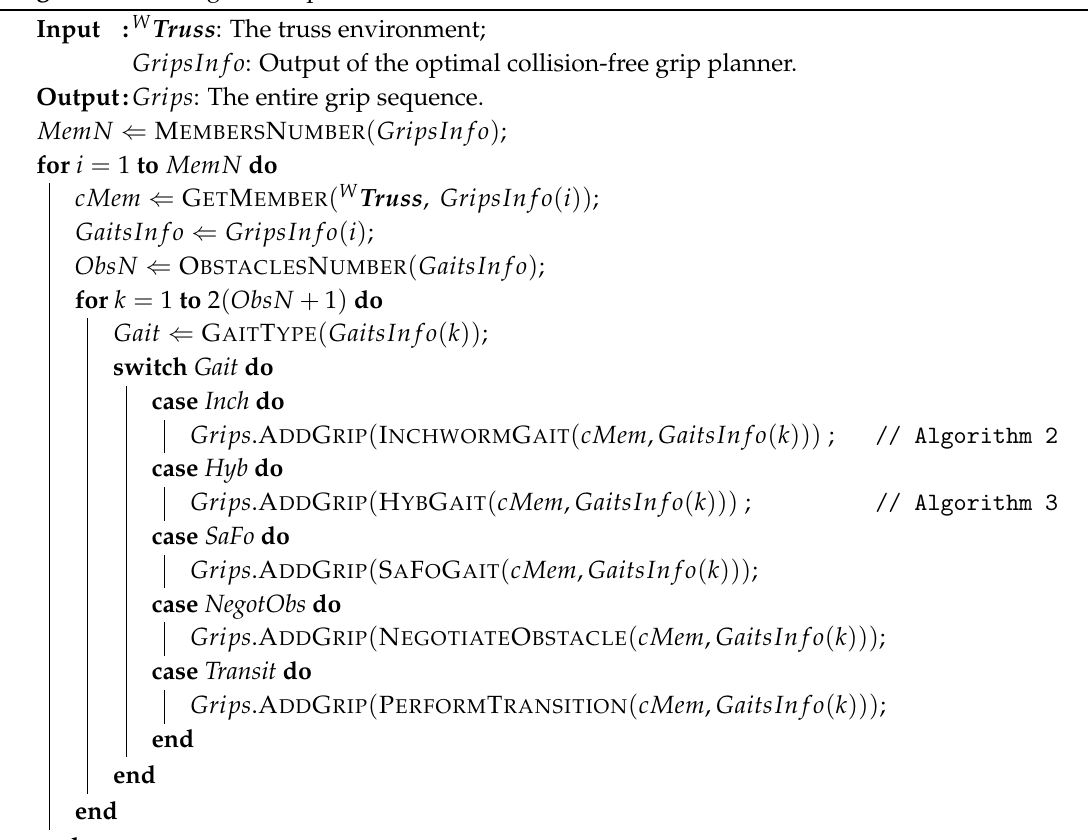
Algorithm 1: The gait interpreter